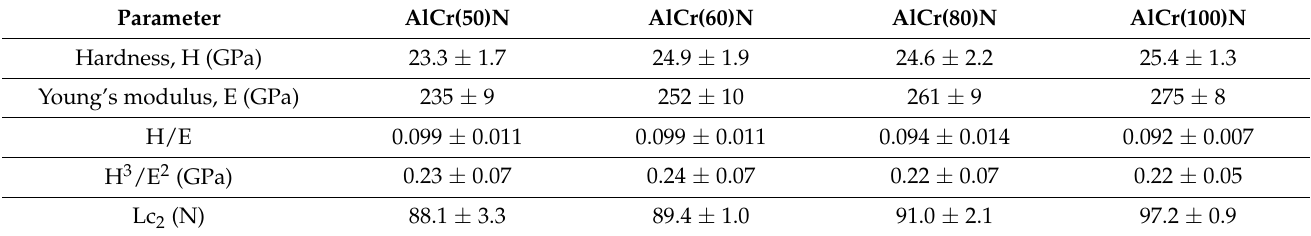
Table 2. Mechanical properties of f AlCrN coatings formed at various arc